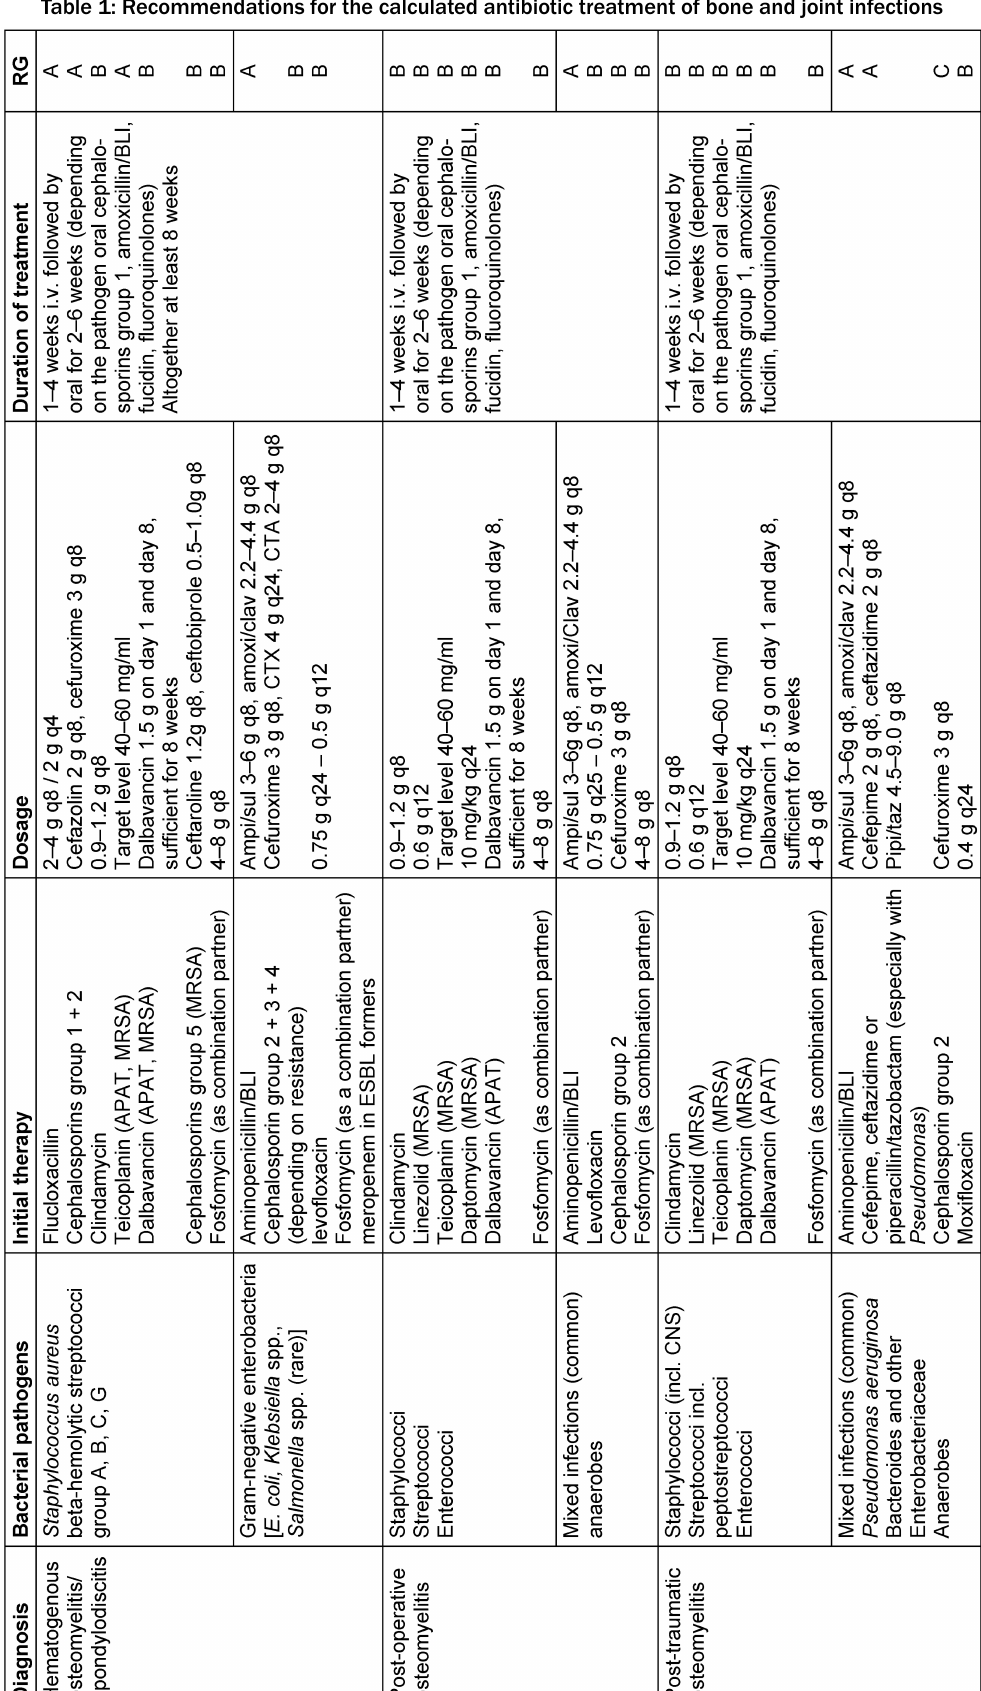
Table 1: Recommendations for the calculated antibiotic treatment of bone and joint